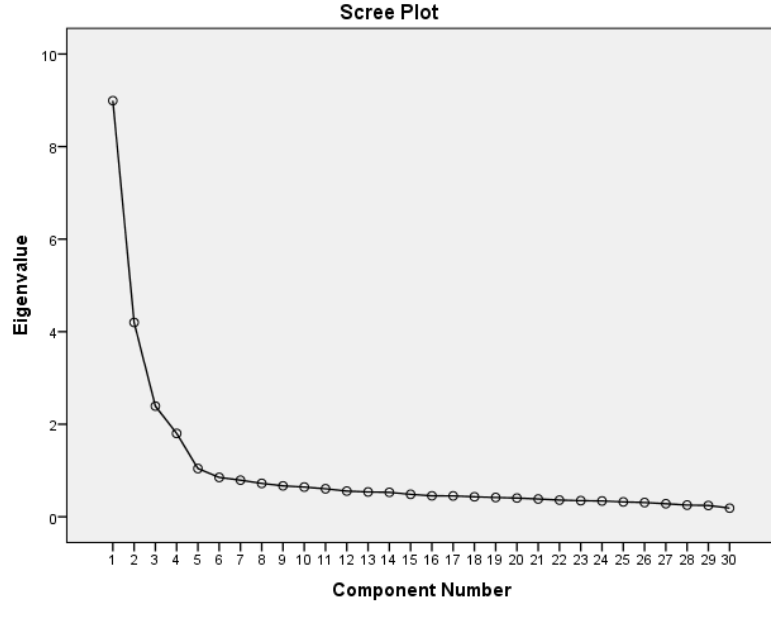
Figure 1. The chart indicating the factor number. Figure 1 shows that the breakpoint occurred after the 5th factor, and the factor eigenvalue (Table 4) dropped below one after this factor. Accordingly, the scale was found to be a five-factor scale. Table 2 shows that a five-factorial structure explained 61.4% of the total variance. Accordingly, the five factors identified were: goal setting, help seeking, self-study strategies, managing physical environment, and effort regulation. Table 4 Factor Eigenvalue and Variance